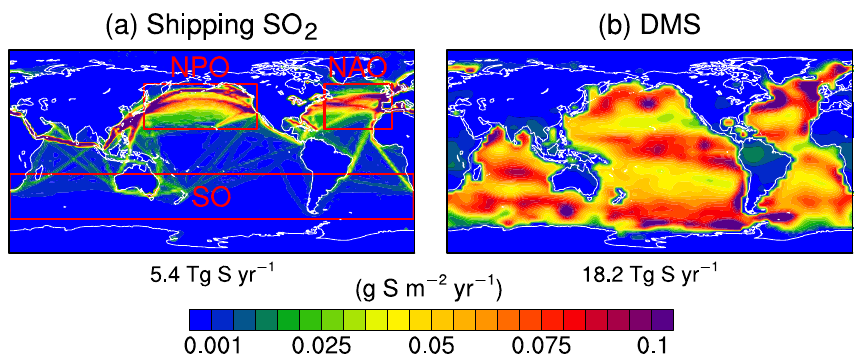
Figure 1. Spatial patterns of annual means of sulfur emissions (gSm − 2 yr − 1 ) from (a) international shipping and (b) natural DMS in the simulation at the reference emission level (i.e., ShipRef_DMSRef). The numbers below each panel are the total global annual emissions. Three regions are selected for further analysis: the North Pacific Ocean (NPO; 20–60 ◦ N, 140–240 ◦ E), the North Atlantic Ocean (NAO; 20–60 ◦ N, 300–360 ◦ E), and the Southern Ocean (SO; 20–60 ◦ S, 0–360 ◦